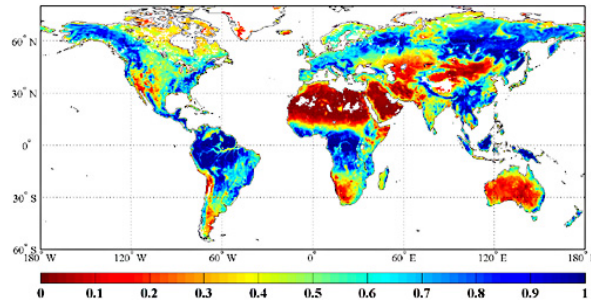
Fig. 9. Regions with high correlation coefficient ( R > 0 . 65) be- tween rescaled AMSR-E and rescaled ASCAT for 2007.